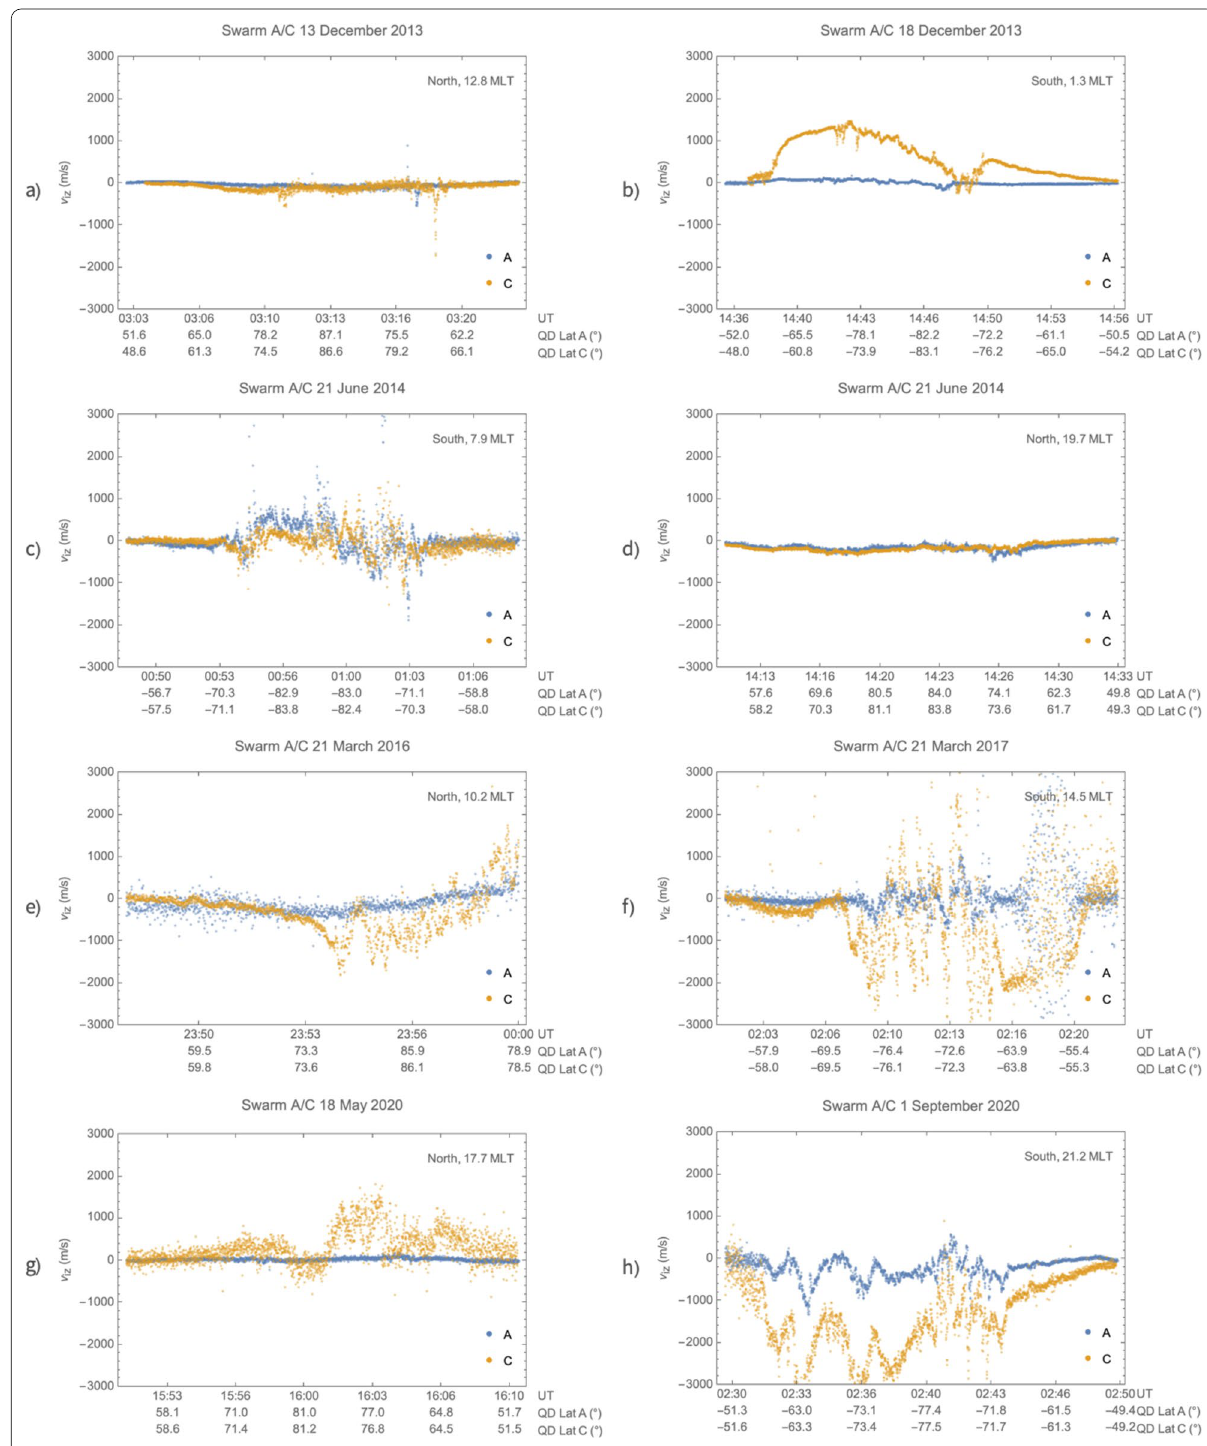
Fig. 12 Examples of realistic and unexpected vertical ion drift from Swarm A and C at various epochs of the mission. Each series is from high latitudes, poleward of quasi-dipole latitudes of ± 50 ◦ . Cross-track horizontal ion drifts ( v iy ) from the TII cross-track ion drift dataset, version 0302, are shown for Swarm A (blue dots) and C (yellow dots). The hemisphere (north or south) and magnetic local time at the beginning of the interval are shown inset in each plot. See the “Swarm TII flight performance” section for